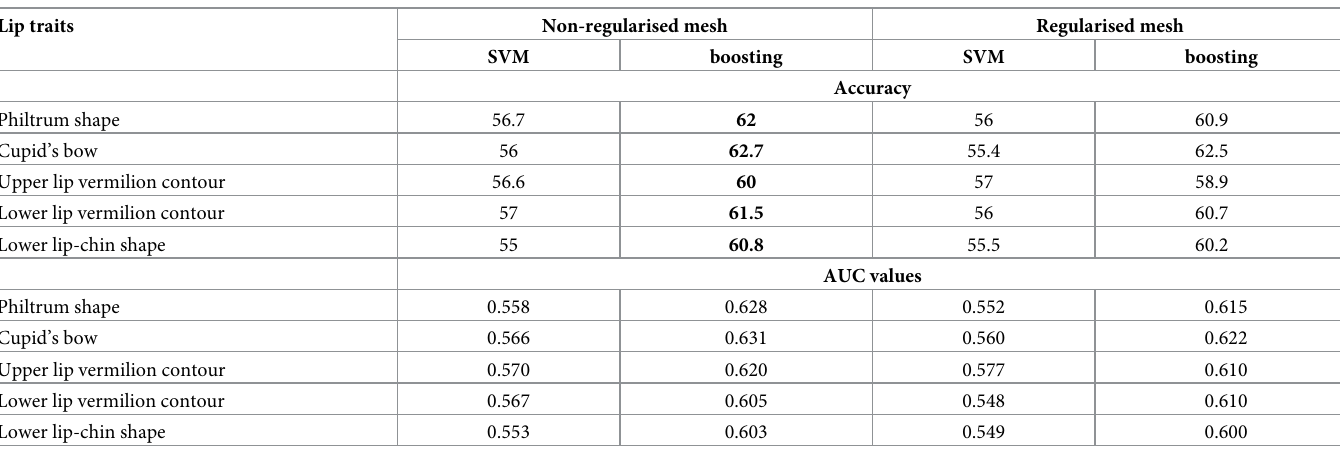
Table 3. Classification results based on Euclidean distance.